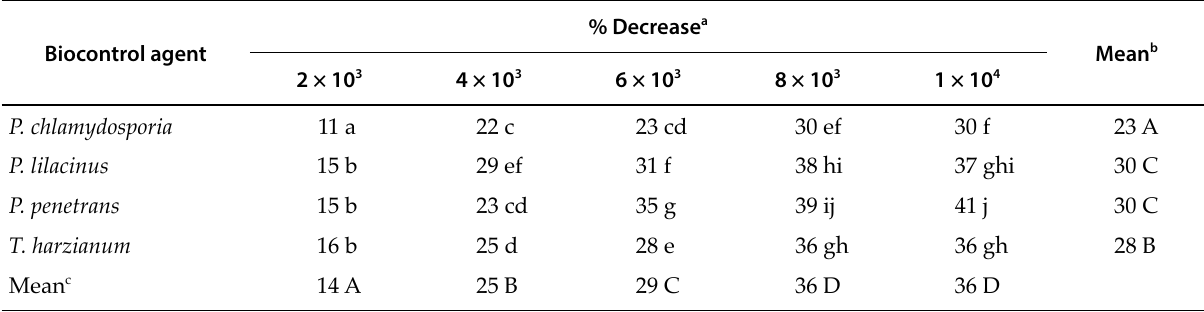
Table 7. Mean proportional decreases in number of egg masses on okra plant roots after treatments with different nema - tode biocontrol agents applied at different propagule concentrations.